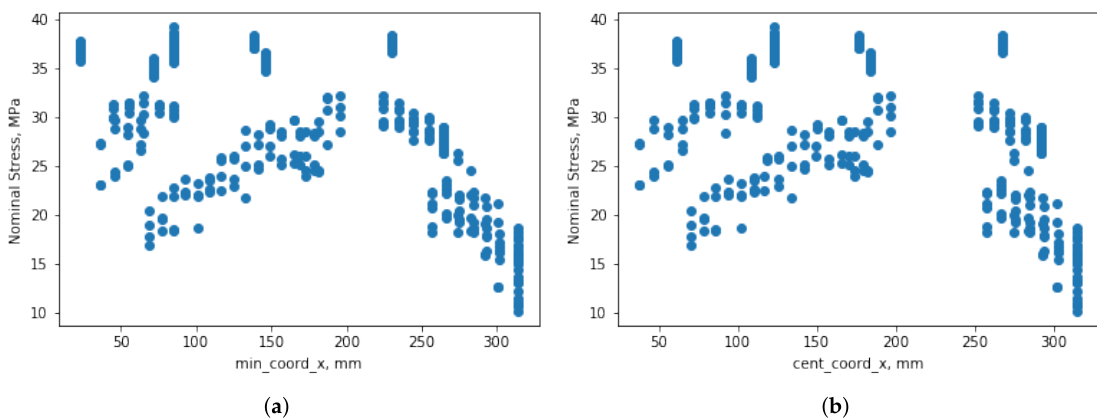
Figure 11. Comparisson of the correlations between Nominal Stress and coordinates in the X-axis (for all data) ( a ) Nominal Stress vs minimal coordinate in the X-axis. ( b ) Nominal Stress vs central coordinate in the x